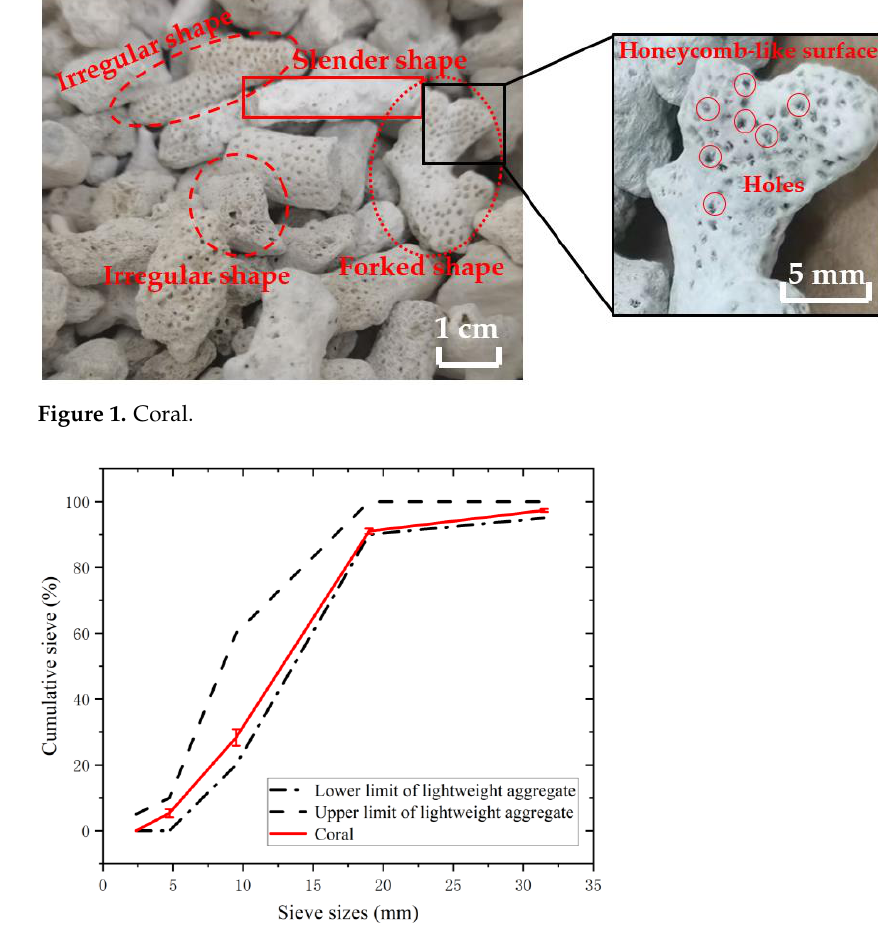
Figure 2. Coral aggregate gradation. Table 1. Bulk density, apparent density, and porosity of coral aggregate